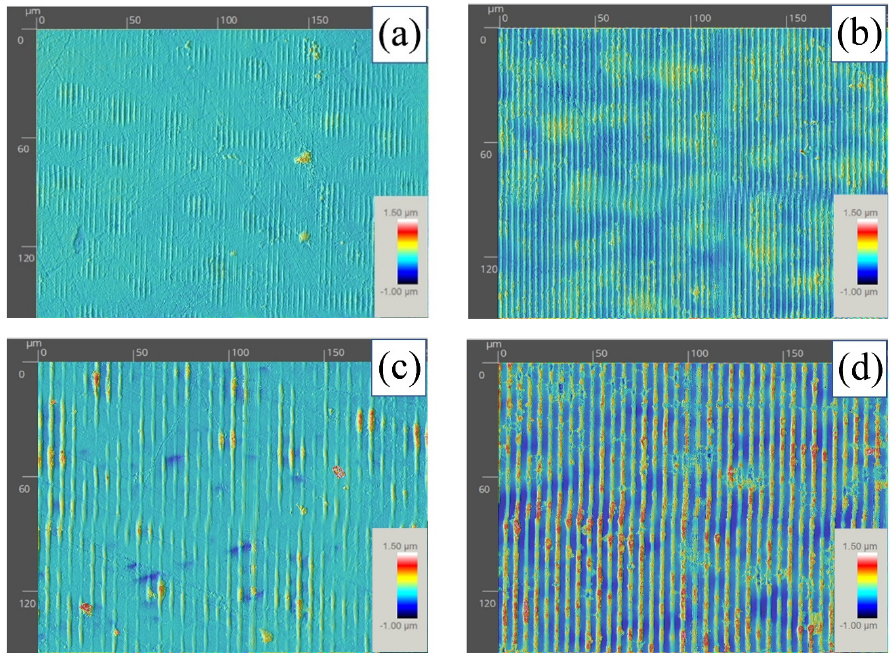
Figure 3. Confocal topographies of structured samples with spatial periods Λ of 3 µm ( a , b ) and 6 µm ( c , d ) using 2 (left) and 6 (right) laser pulses of 0.47 J/cm 2 .